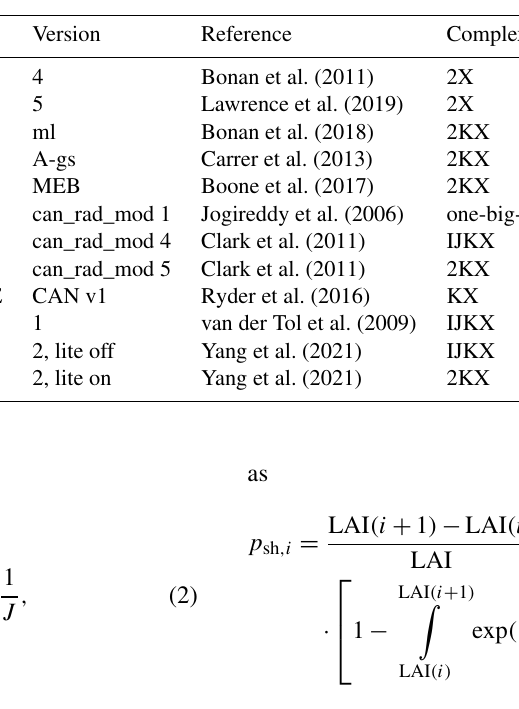
Figure 2. Non-linear leaf responses to the environmental and physiological parameters. (a) Responses of stomatal conductance to water vapor ( g sw ; cyan solid curve) and net photosynthetic rate ( A net ) to absorbed photosynthetically active radiation (APAR). The black dotted vertical lines indicate two leaves at low- and high-light conditions. Mean behavior of the two leaves ought to be the closed circles on the colored dotted lines. However, using mean APAR for the leaves would result in overestimated g sw and A net (open circles). (b) Non-linear g sw and A net responses to leaf photosynthetic capacity, represented by the maximum carboxylation rate ( V cmax ). Environmental and leaf physiological settings for the simulations are the following: air and leaf temperatures at 298.15K, atmospheric vapor pressure at 1500Pa (relative humidity at 0.47), atmospheric CO 2 partial pressure at 40Pa, atmospheric pressure at 101325Pa, V cmax (for panel a ) at 60µmolm − 2 s − 1 , and maximal stomatal conductance at 0.3molm − 2 s − 1 . Table 1. A list of vegetation models corresponding to our tested canopy complexity schemes. CLM: Community Land Model. ISBA: Interac- tions between soil–biosphere–atmosphere. JULES: Joint UK Land Environment Simulator. ORCHIDEE: Organising Carbon and Hydrology In Dynamic Ecosystems. SCOPE: Soil Canopy Observation, Photochemistry and Energy fluxes. 2X: single-layer canopy with sunlit and shaded fractions. KX: multiple-layer canopy without sunlit or shaded fractions. 2KX: multiple-layer canopy with sunlit and shaded fractions per layer. IJKX: multiple-layer canopy with sunlit and shaded fractions per layer, with the sunlit fraction being further partitioned based on leaf inclination and azimuth angular